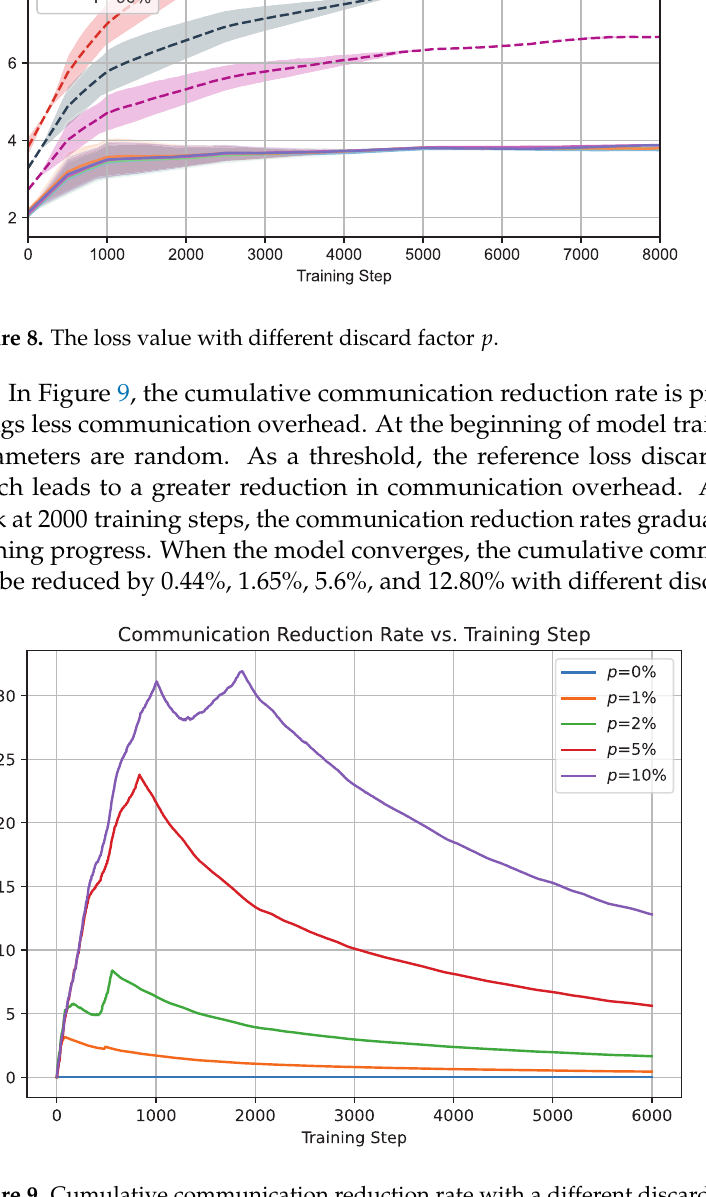
Figure 9. Cumulative communication reduction rate with a different discard factor p